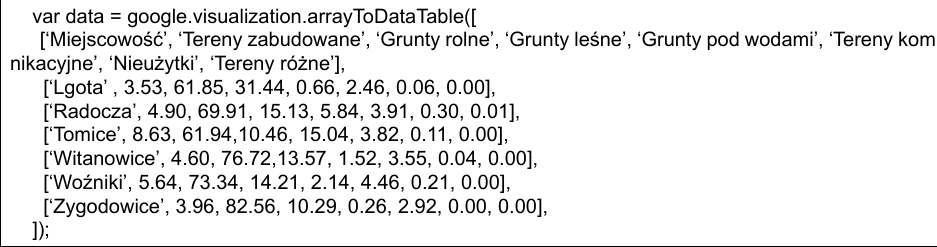
Table 8. JavaScript code representing a array of data for diagrams Google Charts var data = google.visualization.arrayToDataTable([ [‘Miejscowość’, ‘Tereny zabudowane’, ‘Grunty rolne’, ‘Grunty leśne’, ‘Grunty pod wodami’, ‘Tereny komu­ nikacyjne’, ‘Nieużytki’, ‘Tereny różne’], [‘Lgota’ , 3.53, 61.85, 31.44, 0.66, 2.46, 0.06,